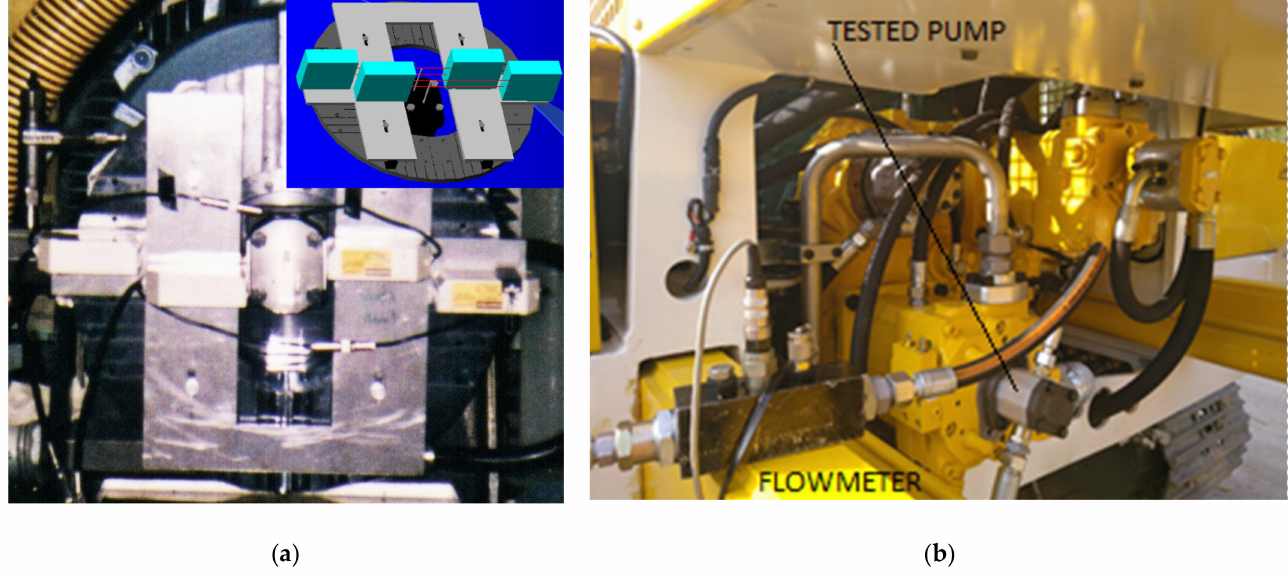
Figure 5. ( a ) Test equipment used to measure the floating bushing motion; ( b ) in-field tests of the LLAMADA P140 drilling